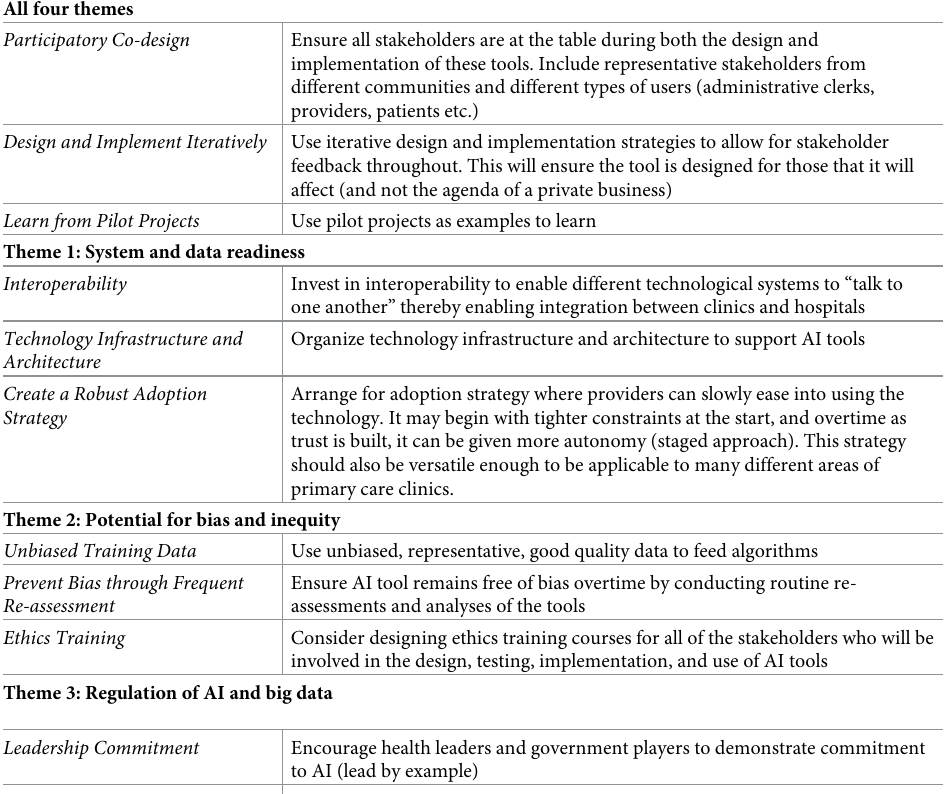
Table 1. Strategies to promote adoption based on each